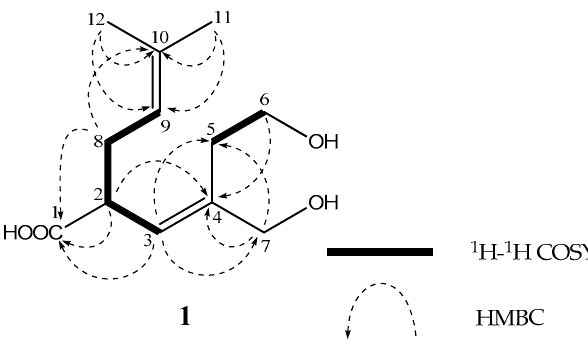
Figure 2. Selected 1 H– 1 H COSY and HMBC correlations of 1 .